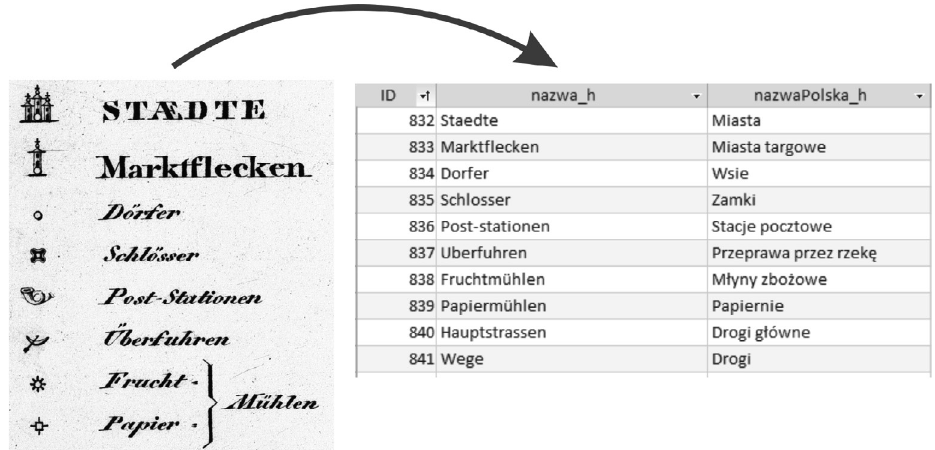
Fig. 1. Key to symbols of the Liesganig map (1:288,000, 1824). While transforming map legend to the database format, names of topographic feature types were considered both in original notation (i.e. German) and Polish